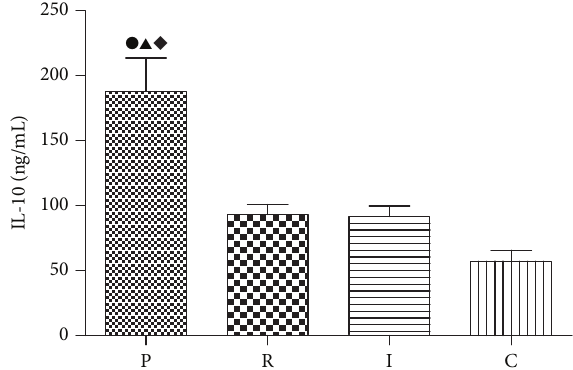
Figure6:Integratedopticaldensity(IOD)ofTGF- 𝛽 1inlungtissues. Integrated optical density (IOD) of TGF- 𝛽 1 was analyzed by Image- Pro Plus analysis system. PAO1 group (P), Δ lasI Δ rhlI group (I), Δ lasR Δ rhlR group (R), and control group (C). e : compared with control group, 𝑝 < 0.05 . 󳵳 : statistically significant differences between PAO1 and Δ lasR Δ rhlR group, 𝑝 < 0.05 . X : statistically significant differences between PAO1 and Δ lasI Δ rhlI group, 𝑝 < 0.05 .